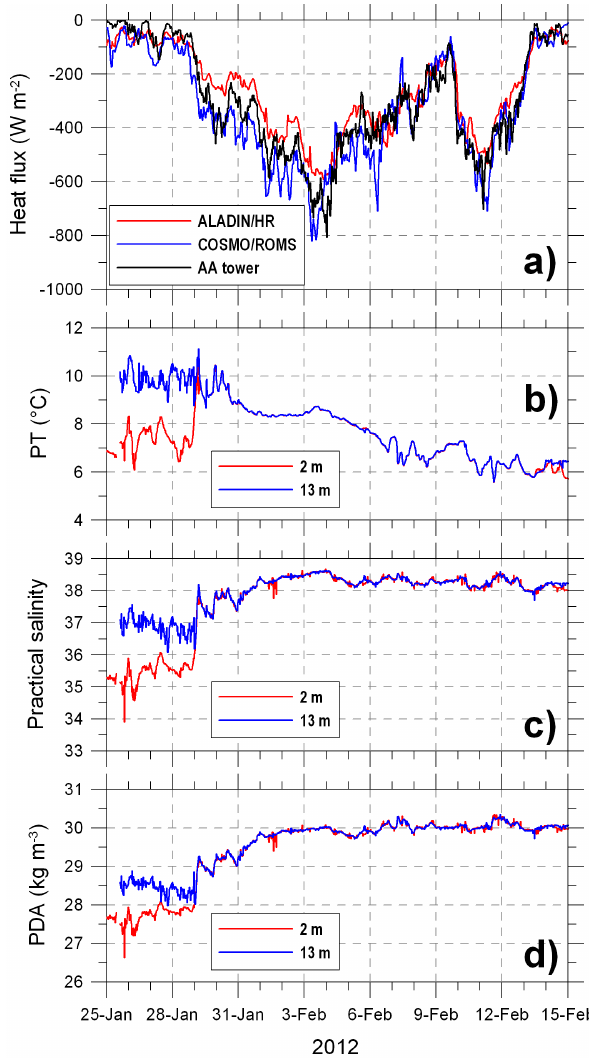
Fig. 4. (a) Time series of turbulent heat fluxes (negative values denote heat loss from the sea) estimated from measurements for station AA (black), together with modelled heat fluxes computed by ALADIN/HR (red) and COSMO/ROMS (blue) models at the grid point nearest to AA, for the period between 25 January and 14 February 2012. Time series of surface (2m) and bottom (13m) (b) potential temperature (PT), (c) practical salinity and (d) poten- tial density anomaly (PDA) during the same period at the AA sta-